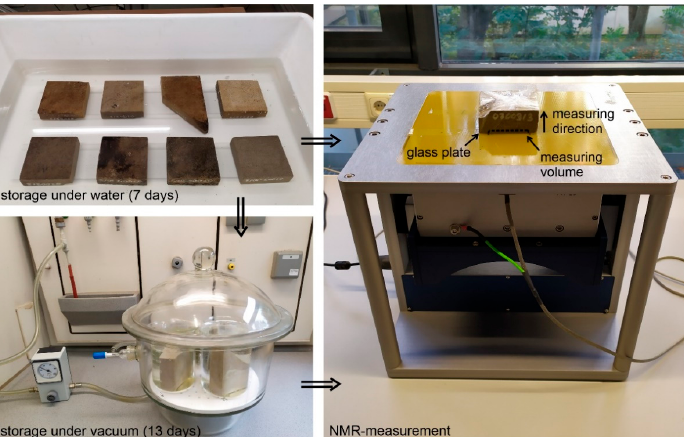
Figure 3. Top left : storage of the samples under water at atmospheric pressure (1 bar) for 7 days. Bottom left : then, the samples were stored at negative pressure (0.05 bar) for 13 days. Right : measuring the relaxation times after each storage period with the unilateral NMR device.